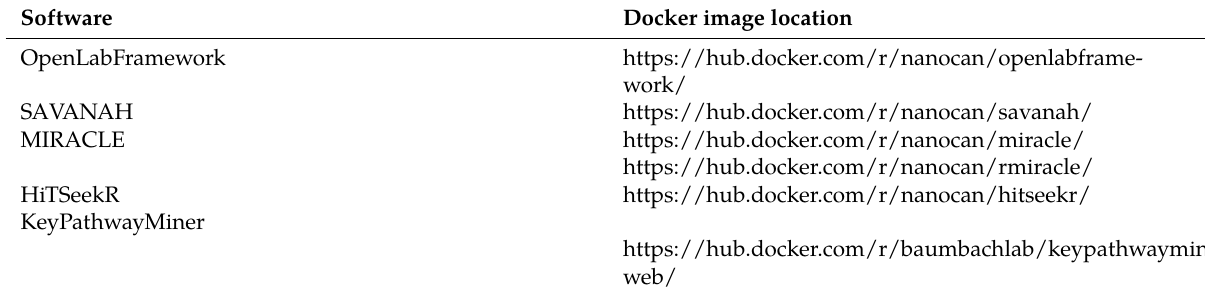
Table 1: DockerHub URLs for the web applications used in the drug discovery